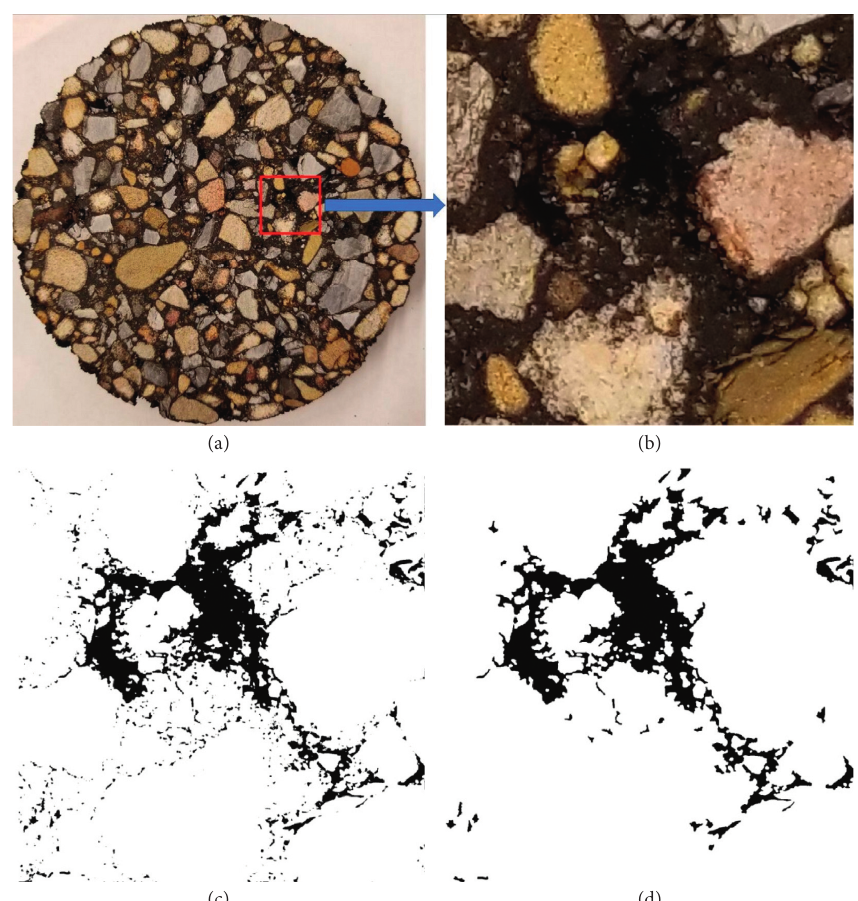
Figure 3: Image processing to capture air voids. (a) Sample’s surface. (b) Local area extraction. (c) Image binarization. (d) Morphological open